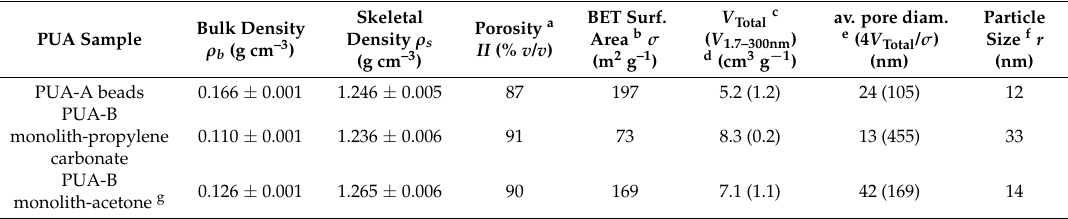
Figure 2. Size distribution of spherical PUA aerogel beads (calculated using IBM SPSS Statistics 24). Sample size: 100 beads. Table 1. Properties of spherical PUA aerogel beads in comparison to PUA monoliths prepared from Desmodur N3300 according to Equation (2).